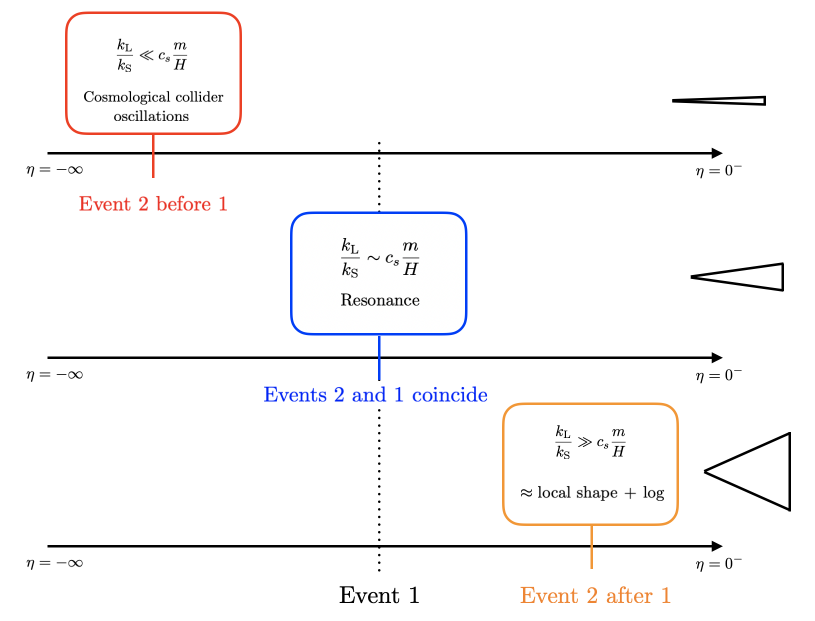
, and event 2 is the mass crossing of the long S